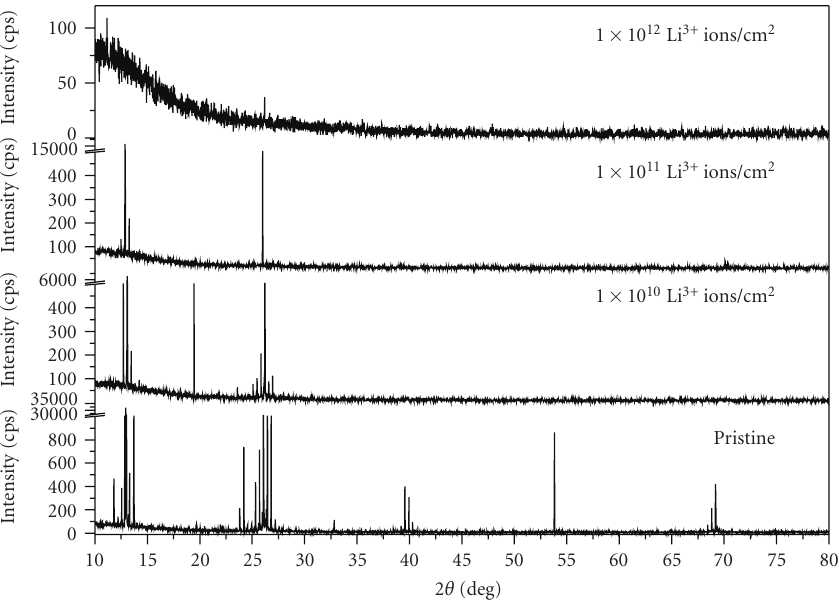
Figure 55: X-ray di ff raction patterns of unirradiated and irradiated L-threonine single crystals at various ion fluencies.